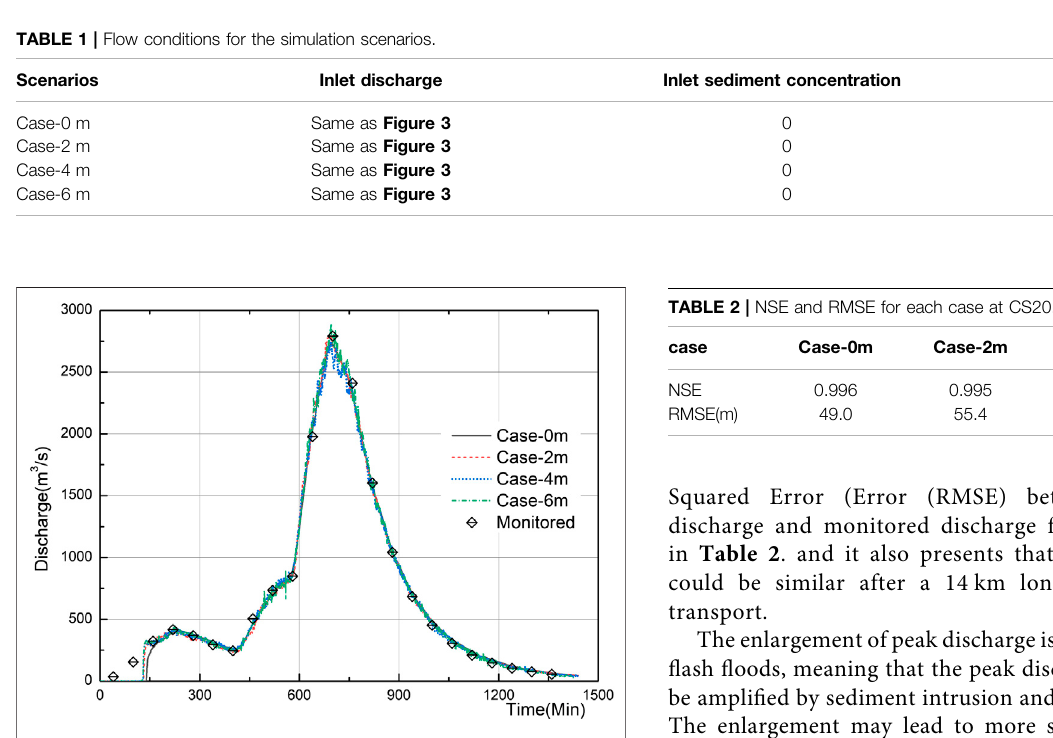
FIGURE 5 | Monitored and simulated discharge at Cross section 20.